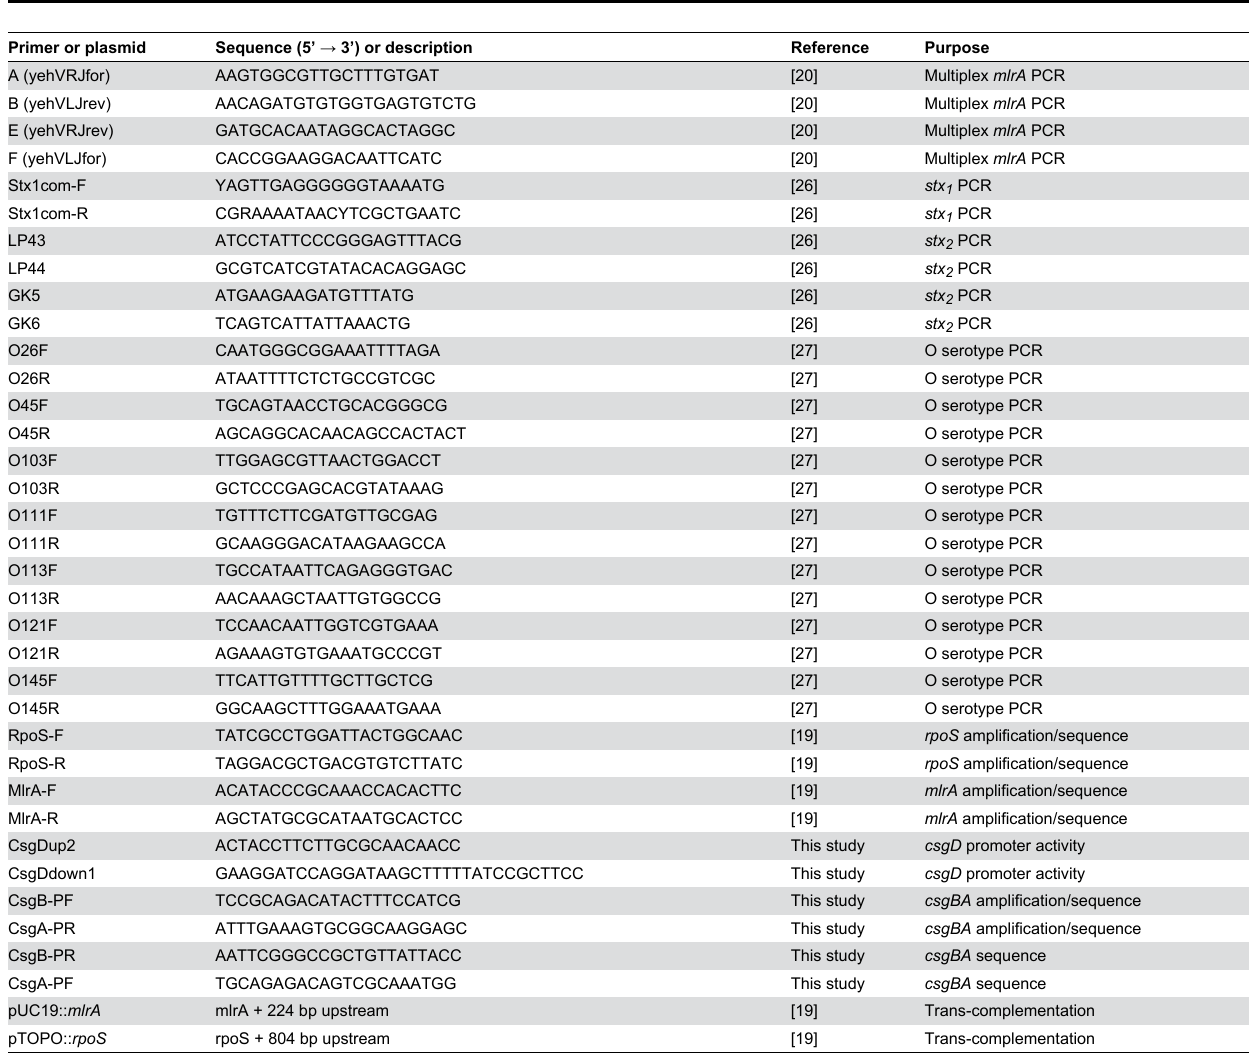
Table 2. Primers and plasmids used in this